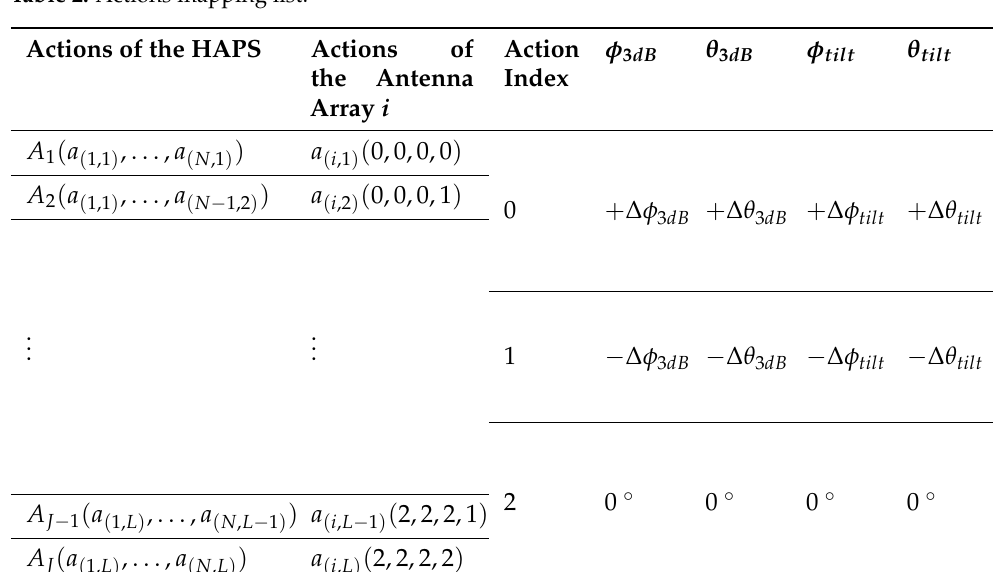
Table 2. Actions mapping